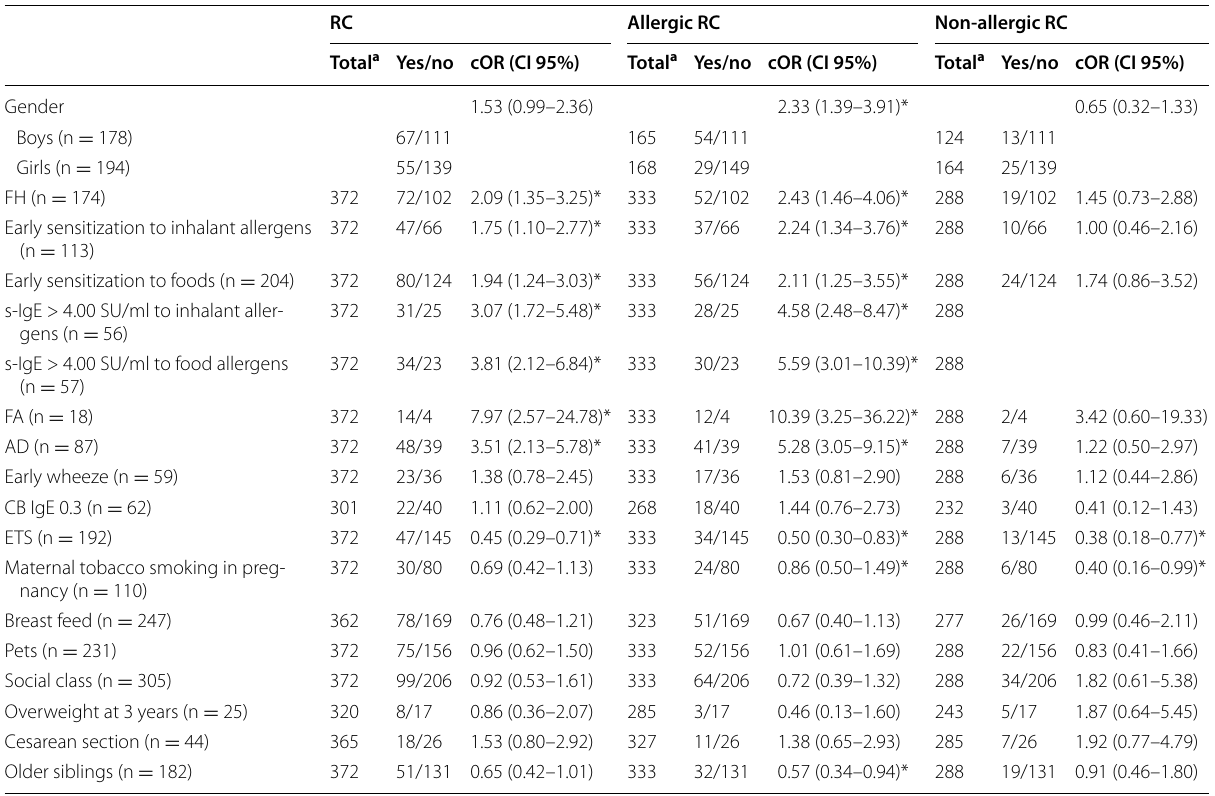
Table 3 Crude effect estimates for the associations between risk factor in early childhood and RC, allergic RC and non- allergic RC at 14 years of age